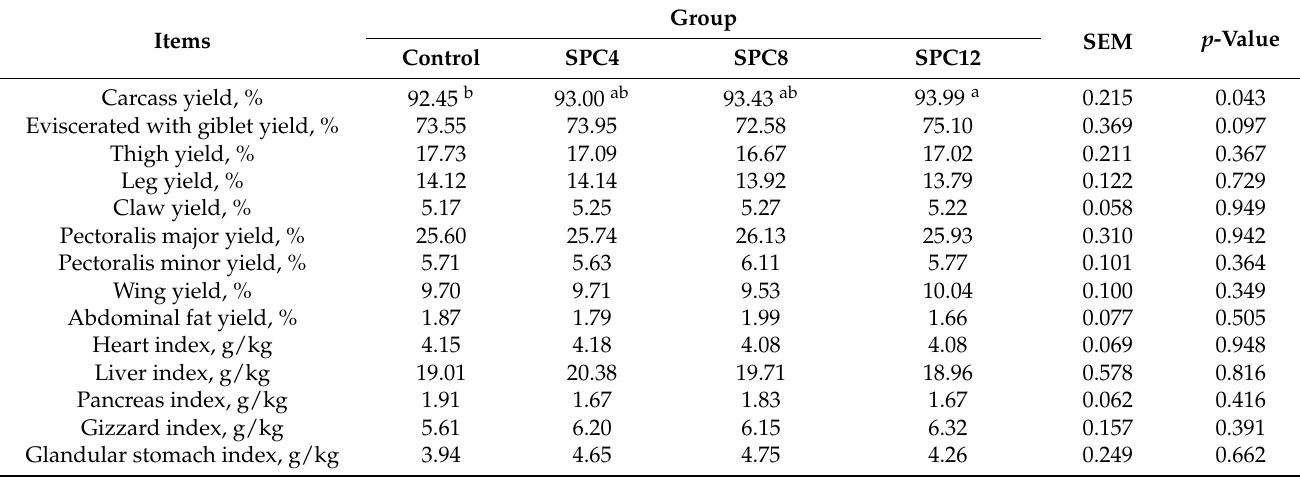
Table 6. Effects of dietary SPC in starter diet on carcass traits of broilers at 42